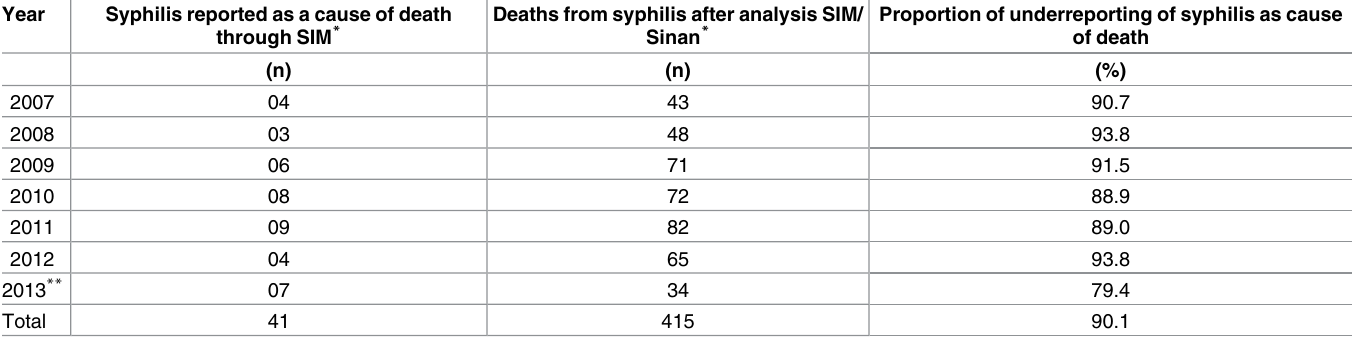
Table 1. Report of CS-associated fetal and infant death and extent of under-reporting of syphilis as a cause of CS death in SIM and Sinan. Forta- leza—Ceara´, Brazil, 2007–2013. Year Syphilis reported as a cause of death Deaths from syphilis after analysis SIM/ Proportion of underreporting of syphilis as cause through SIM * Sinan * of